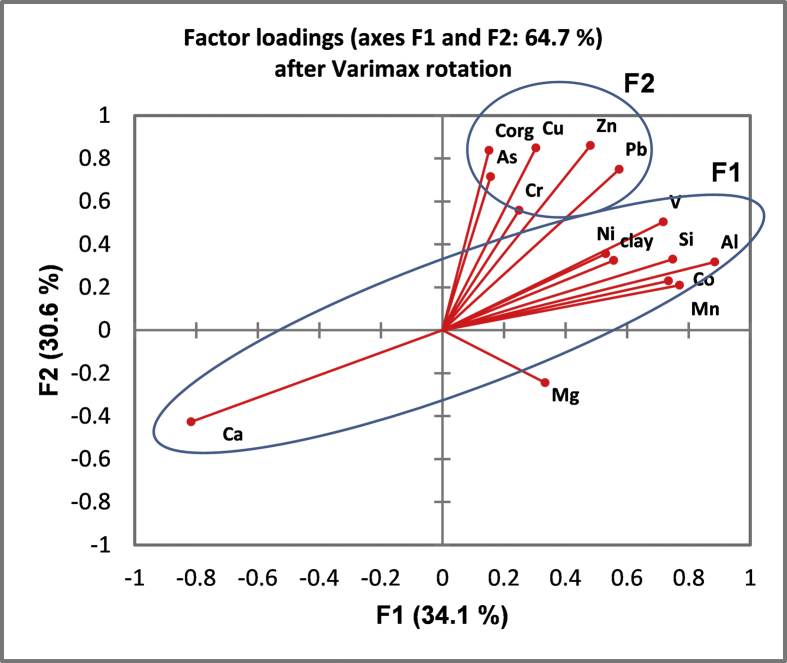
Factor plot after Varimax rotation.